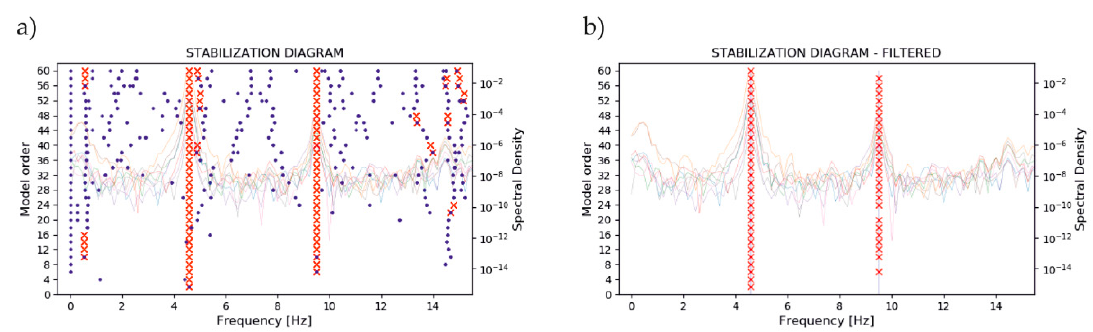
Figure 12. Stabilization diagram created for the gates’ left leaf. ( a ) Classic version; ( b ) Filtered version.